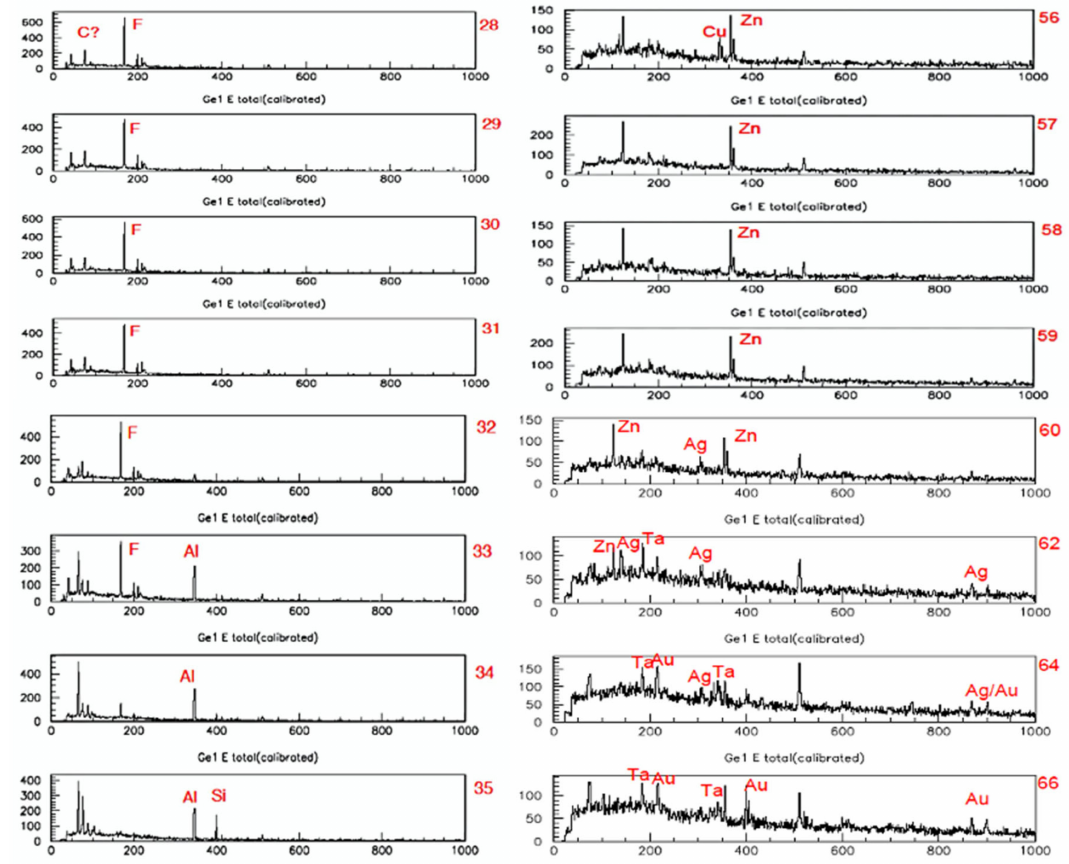
Figure 10. X-ray spectra acquired at different energies of the muon beam in order to scan several depths inside the sample. The sample consisted of several layers of materials (Teflon, Al, Si, Cu, Zn, Ag, Ta, Au) with different thickness placed one after the other in